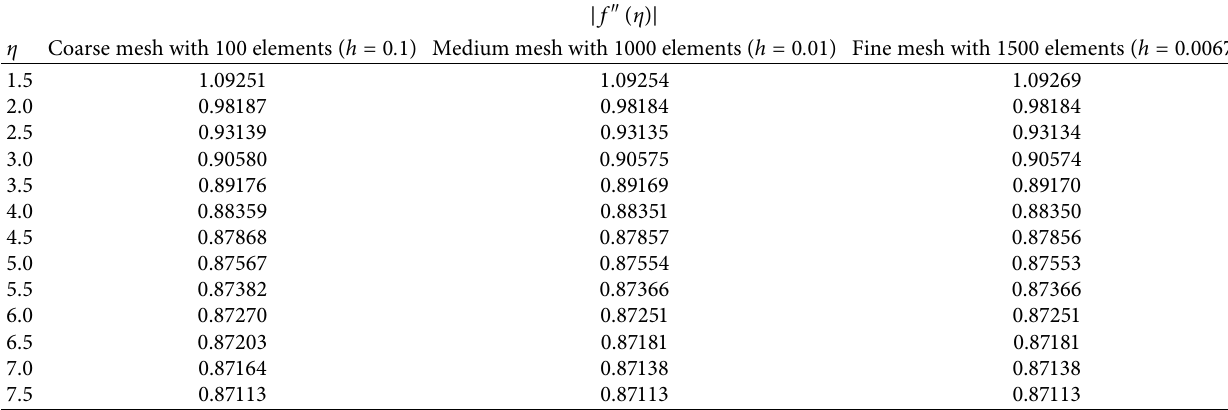
Table 1: Grid-independence test for velocity distribution.